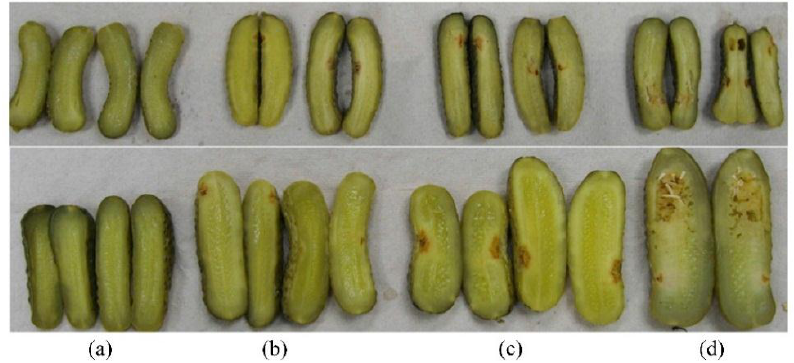
Figure 18. Examples of pest infestation in pickling cucumbers: ( a ) normal; ( b ) slight; ( c ) mild; and ( d ) severe infestation. Reproduced with permission from [86], Copyright Elsevier, 2013.